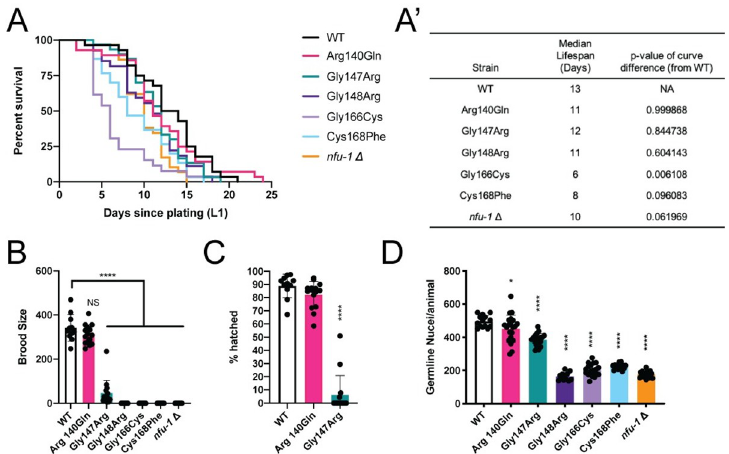
Fig 2. Mutations to nfu-1 affect lifespan and fecundity. (A-A’) Kaplan-Meier survival curve and analysis of nfu-1 mutants (n = 26–30). (B) Total brood size (n = 11–15 broods), (C) embryonic viability (n = 11–15 broods), and (D) L4 germline nuclei of nfu-1 mutants (n = 12–22). A’: Log-rank (Mantle-Cox) analysis with Bonferroni correction for multiple comparisons. B-D: � : p � 0.05; ���� : p � 0.0001 difference between WT and mutant by One-way ANOVA with Dunnett correction for multiple comparisons. NS: Not